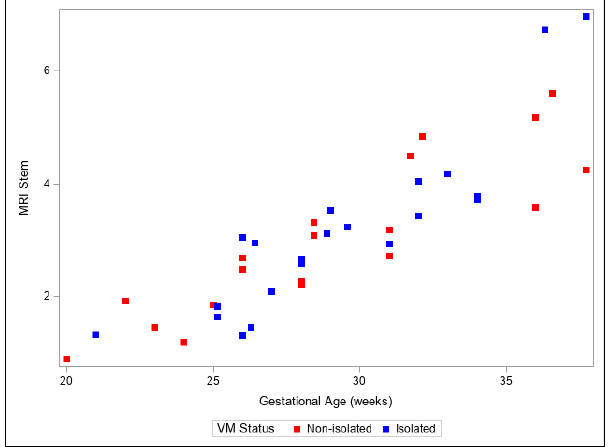
Figure 6. Three-dimensional growth trajectory measurements of brainstem volume in isolated and non-isolated VM.